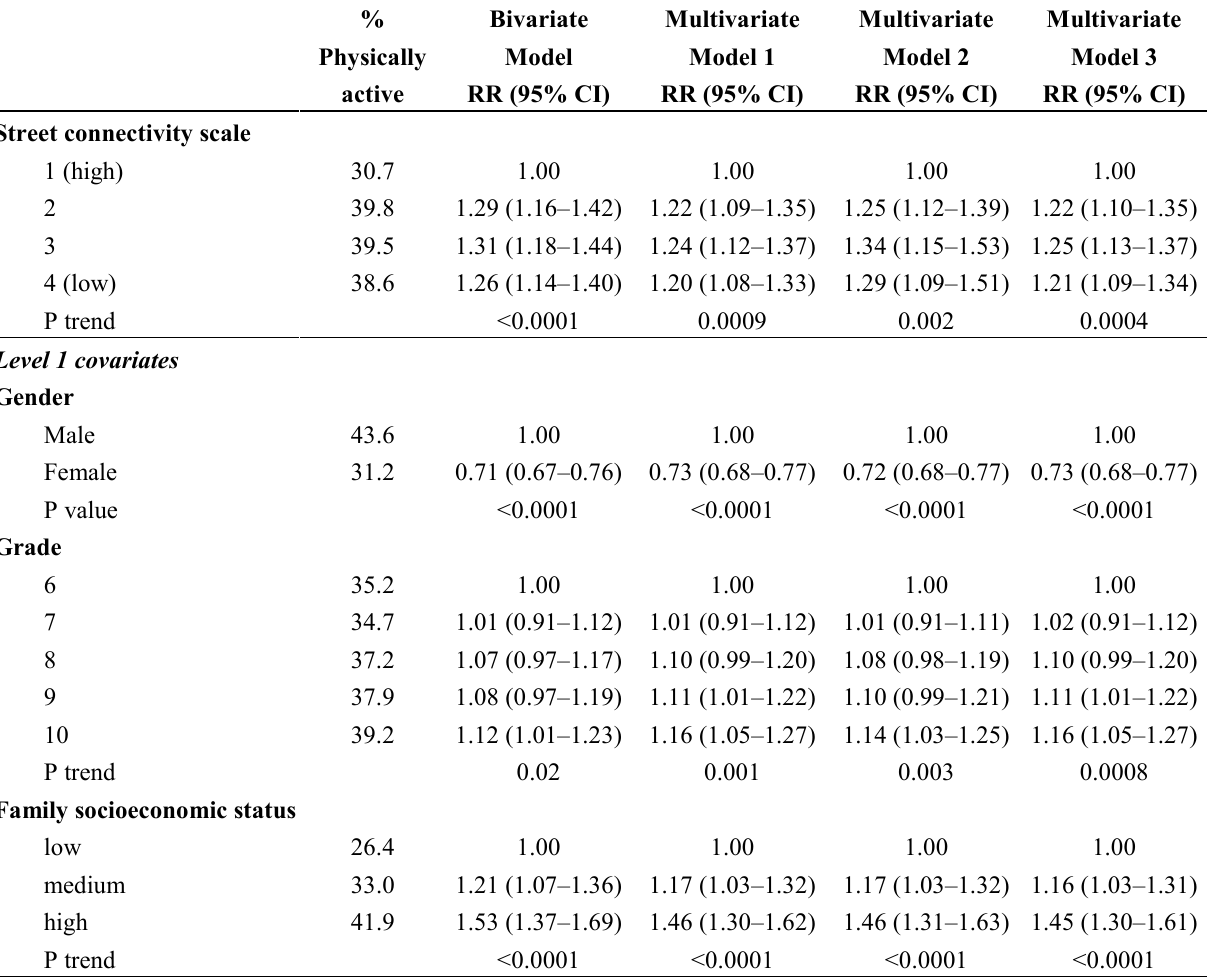
Table 4. Multivariate relations between street connectivity and physical activity (n =